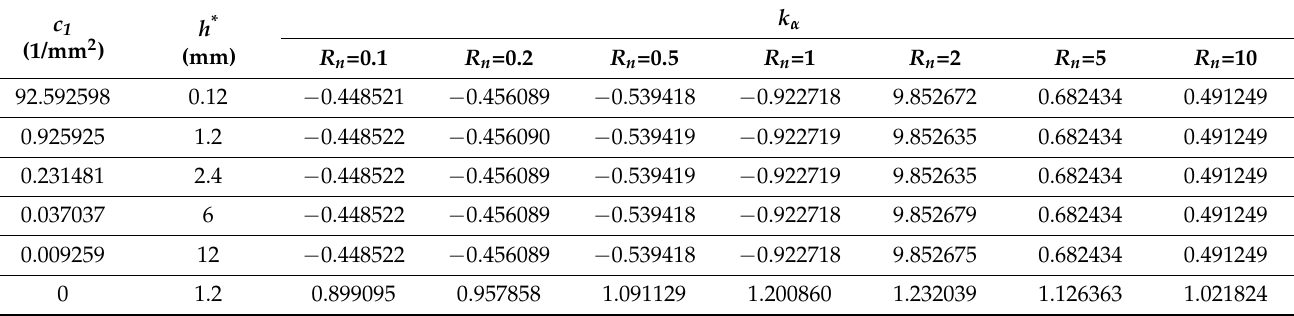
Table 2. Nonlinear varied k α vs. c 1 and R n under T = 100